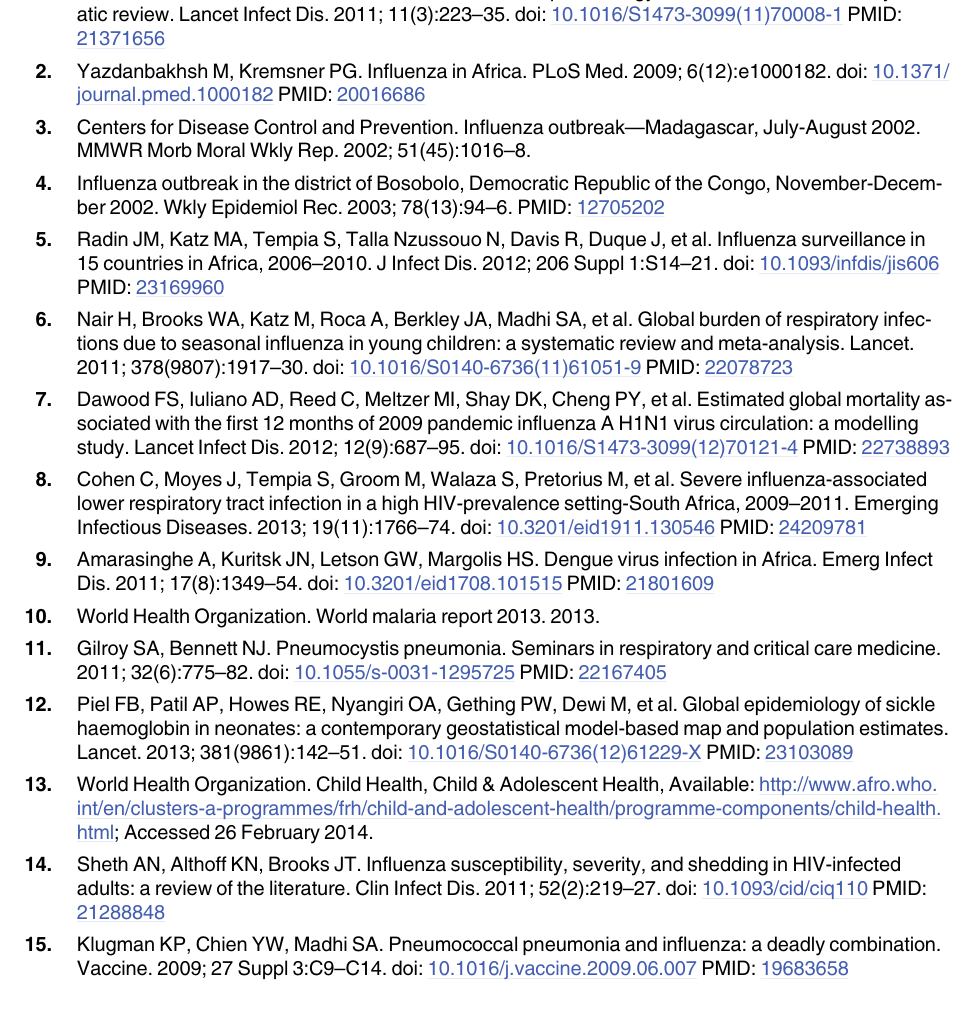
S1 Table. List of studies included in systematic review and their study design, size, and